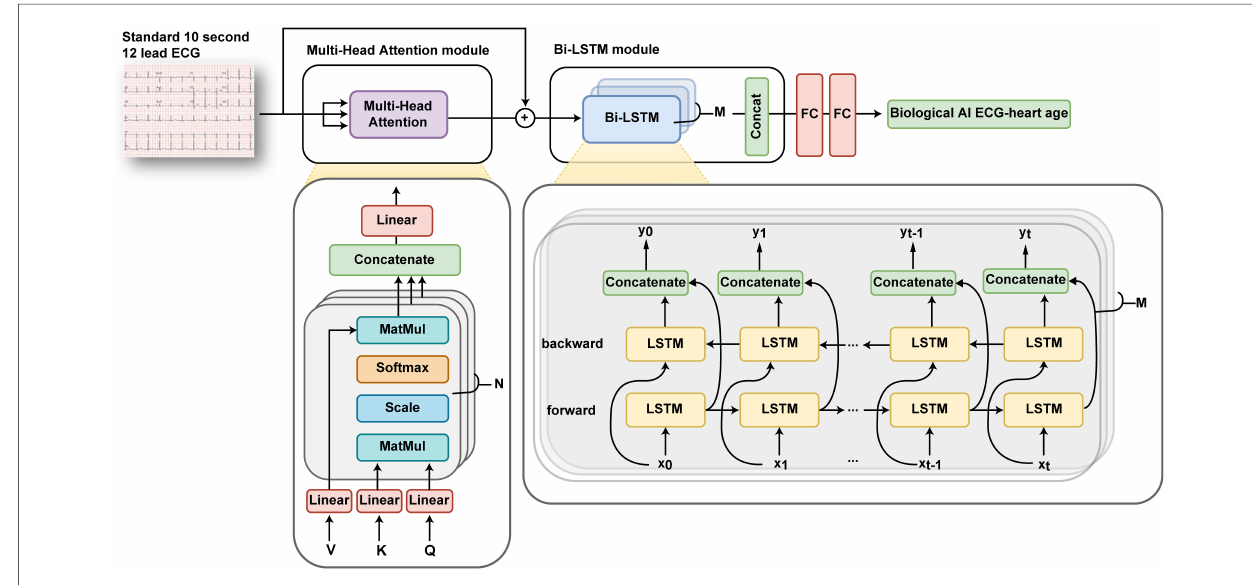
FIGURE 2 Overview of an arti fi cial intelligence-based age prediction algorithm using a 12-lead electrocardiogram. ECG,